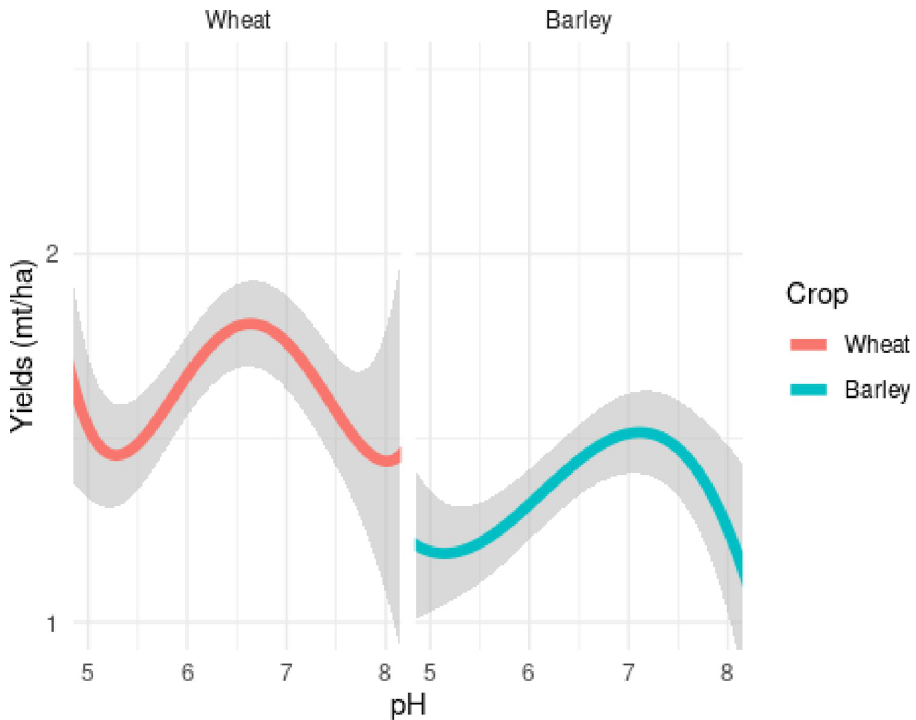
Fig 4. Estimated response of wheat yield to changes in pH.